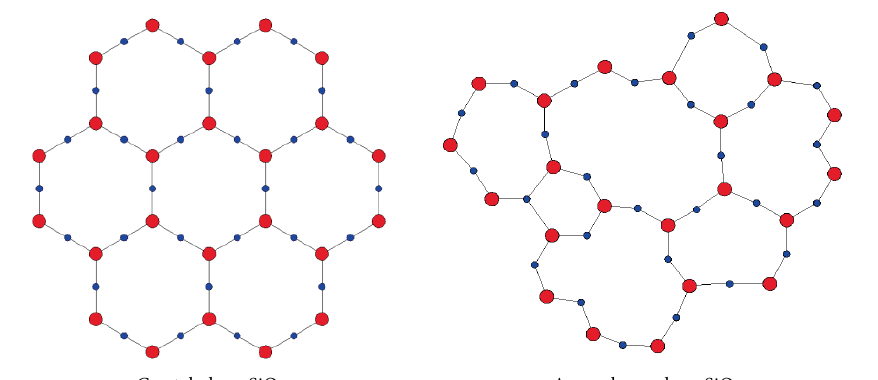
Figure 7: Planar model of molecular structure of SiO